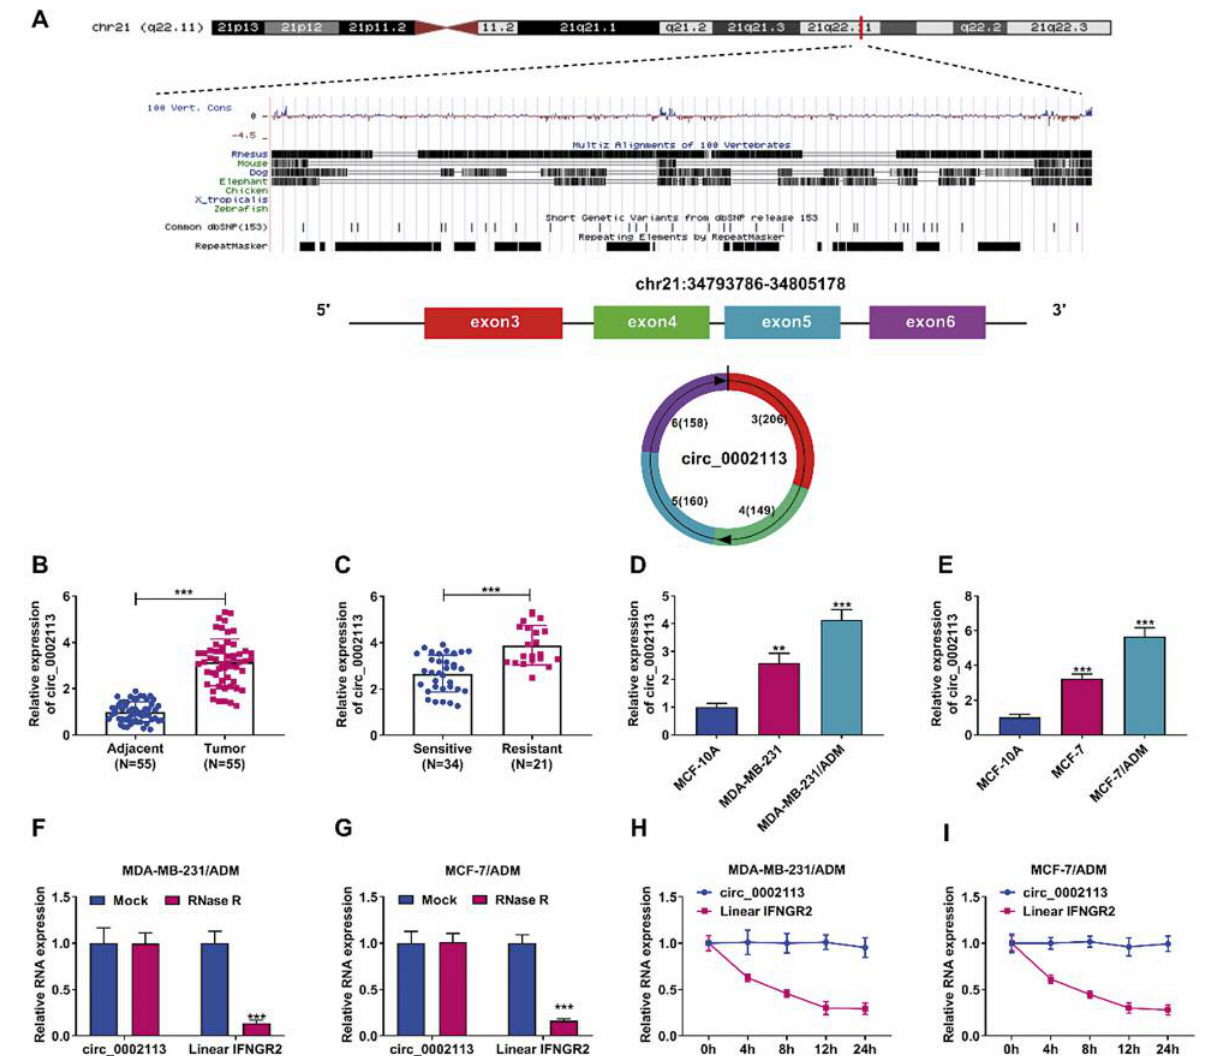
Fig. 1. High level of circ_0002113 in ADM-resistant tissues and cells. (A) The back-splicing frame of ciorc_0002113. (B-E) Circ_0002113 level was detected via RT-qPCR in tissue samples (B-C) and ADM-sensitive or resistant cell lines (D-E). (F-I) Circ_0002113 and IFNGR2 levels were measured via RT-qPCR after treatment with RNase R for total RNA (F-G) and Actinomycin D for ADM-resistant cells (H-I). ** p < 0.01, *** p <